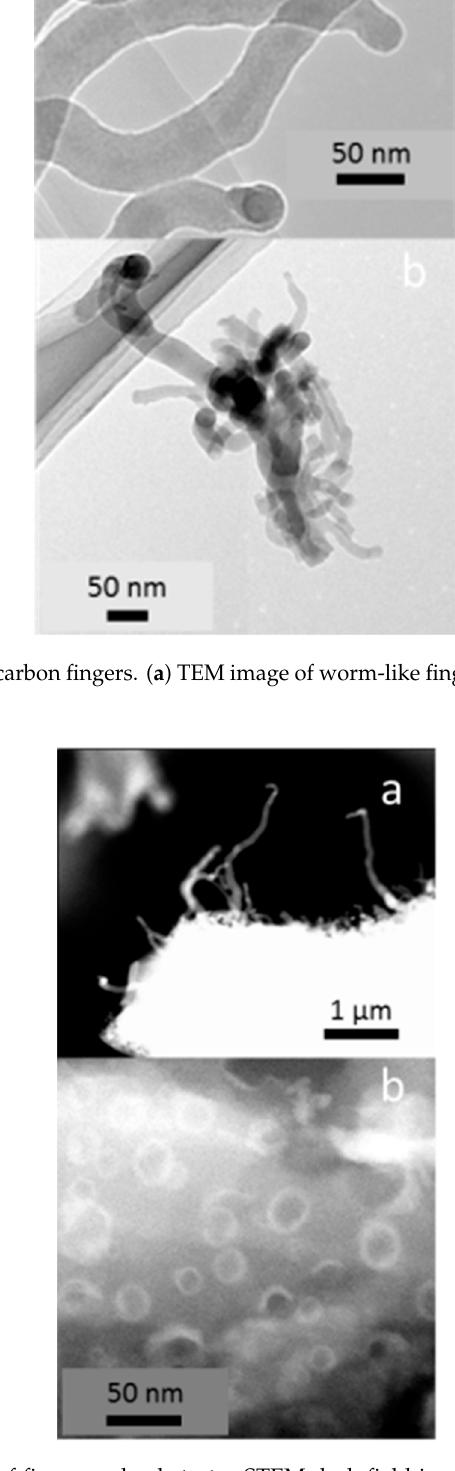
Figure 4. STEM images of finger and substrate. STEM dark field images of ( a ) fingers attached to substrate; ( b ) pits and craters.